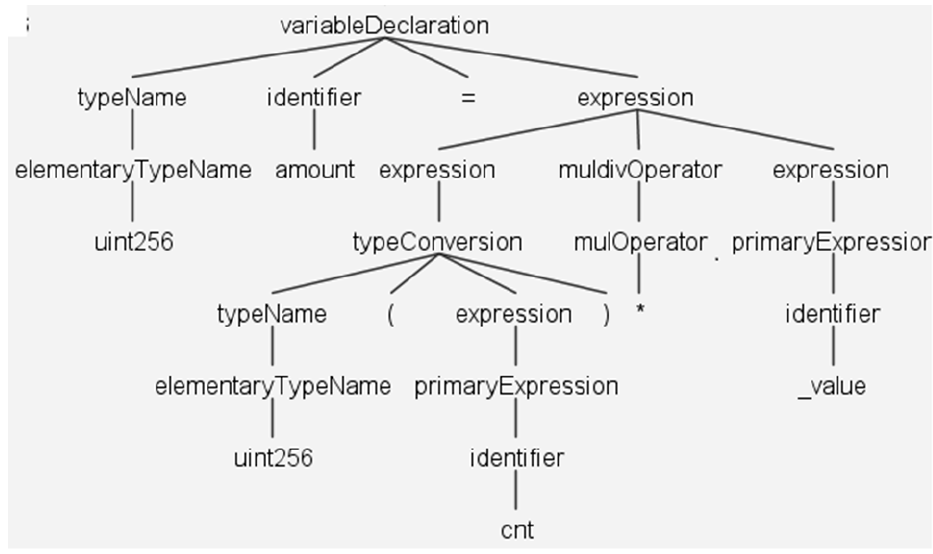
Figure 8. Introduction of Ttest.